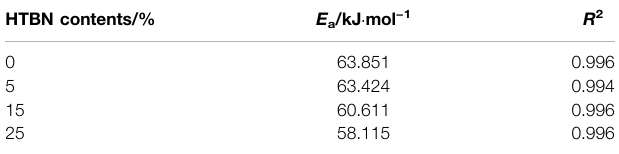
TABLE 3 | Apparent activation energy of the DC conductivity.